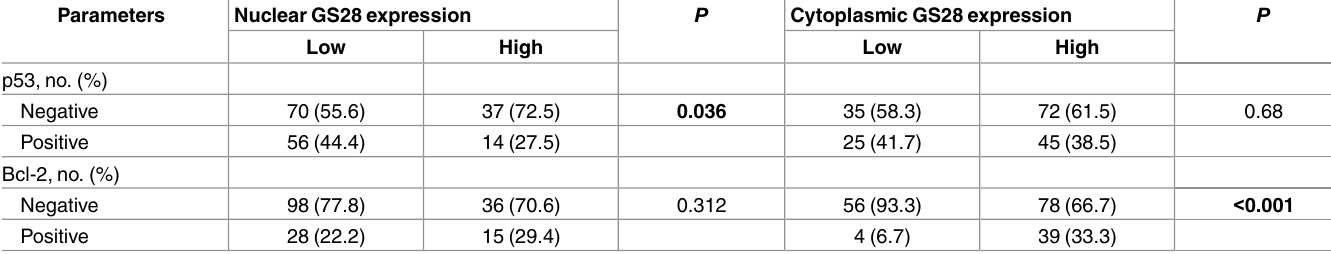
Table 2. Relationship of nuclear expression of GS28 withp53 and Bcl-2 expressionin